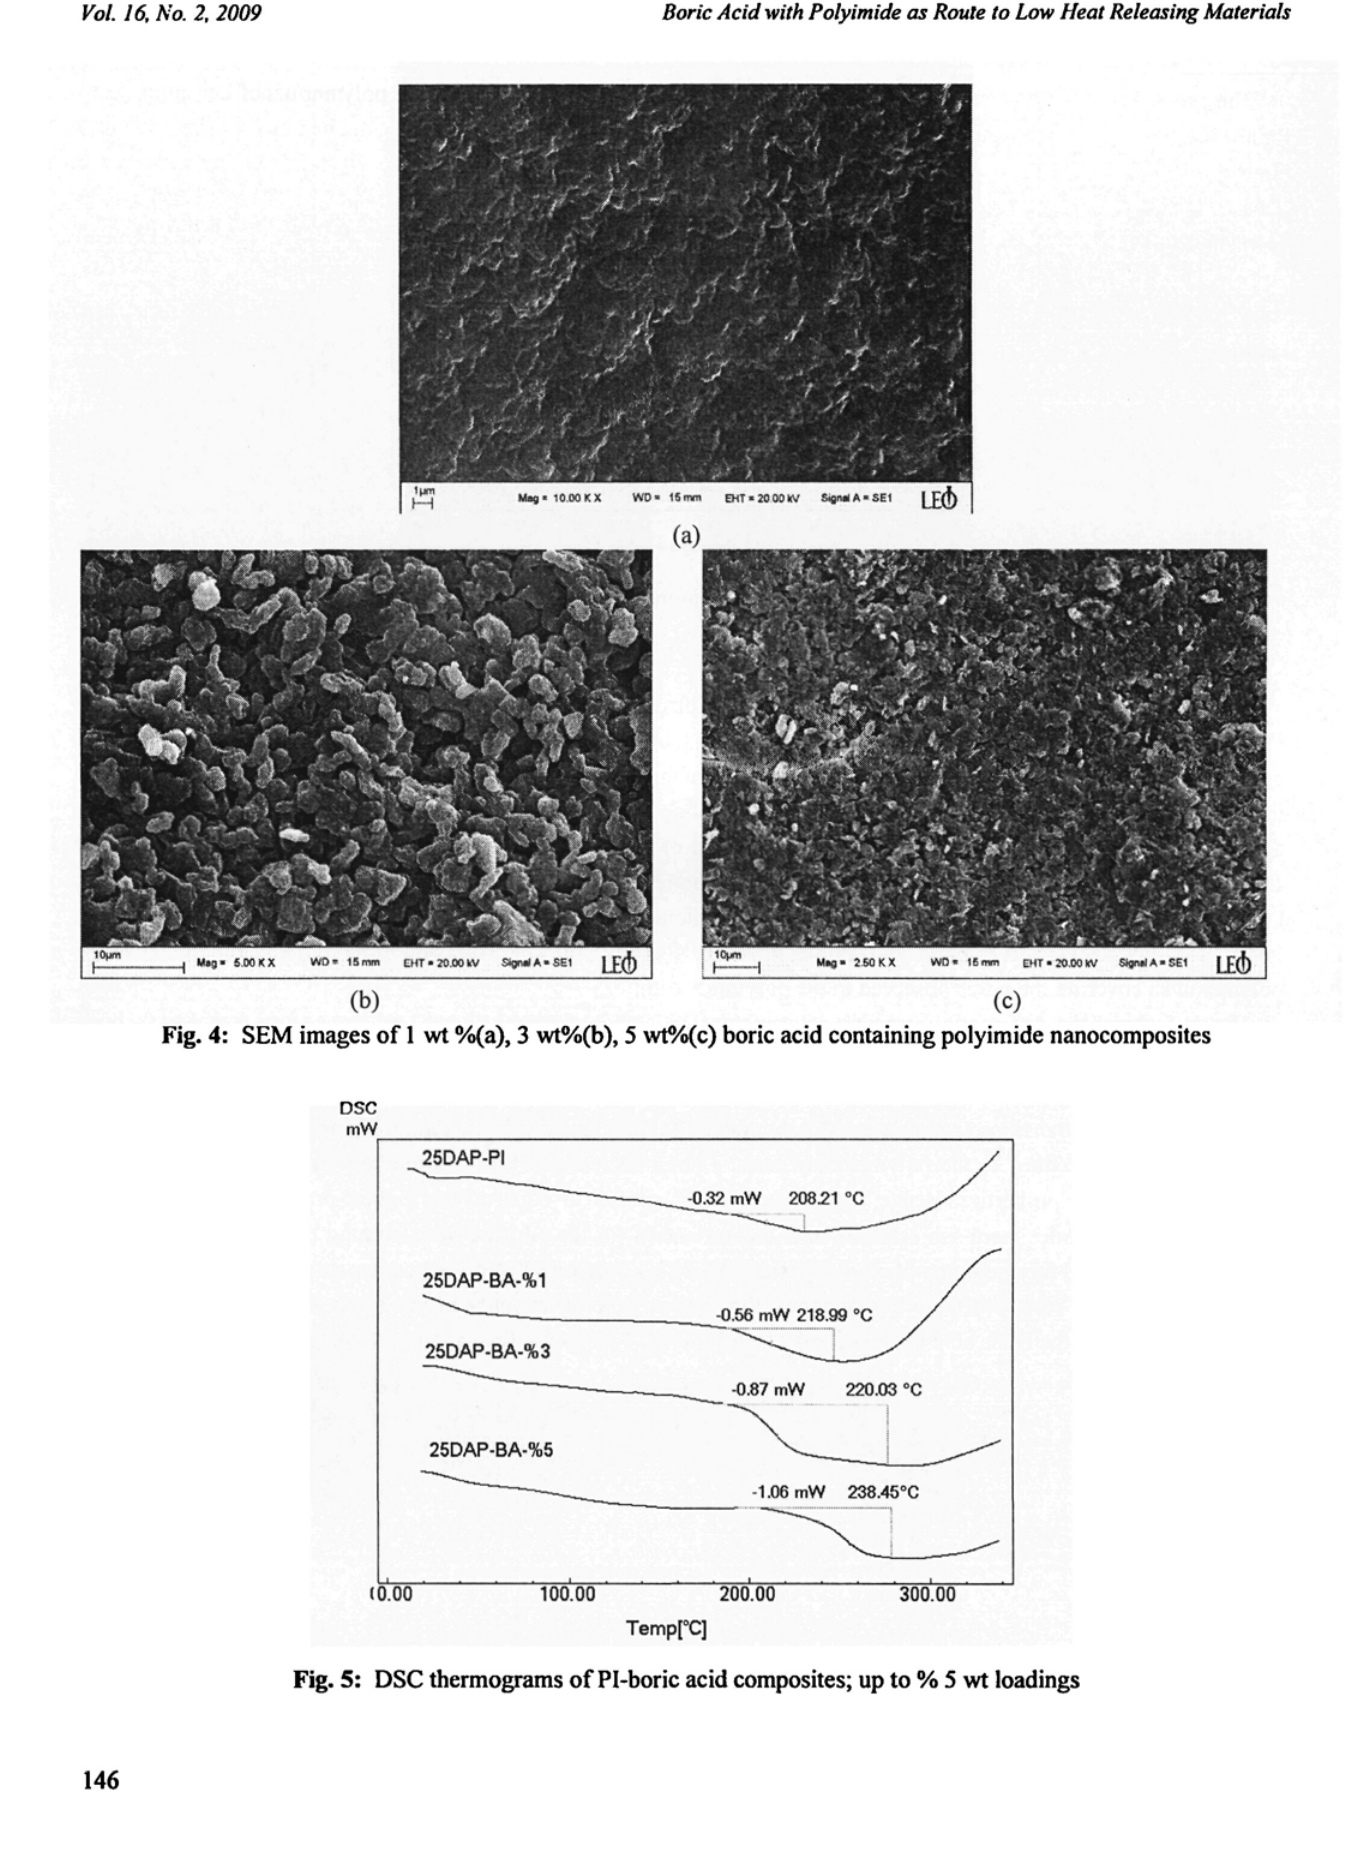
Fig. 4: SEM images of 1 wt %(a), 3 wt%(b), 5 wt%(c) boric acid containing polyimide nanocomposites